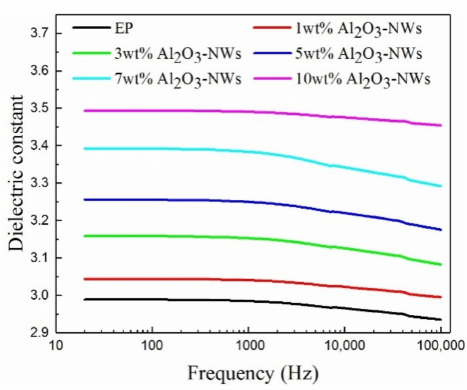
Figure 6. Dielectric constant of Al 2 O 3 -NWs / epoxy resin composites with di ff erent mass ratios as a function of frequency.